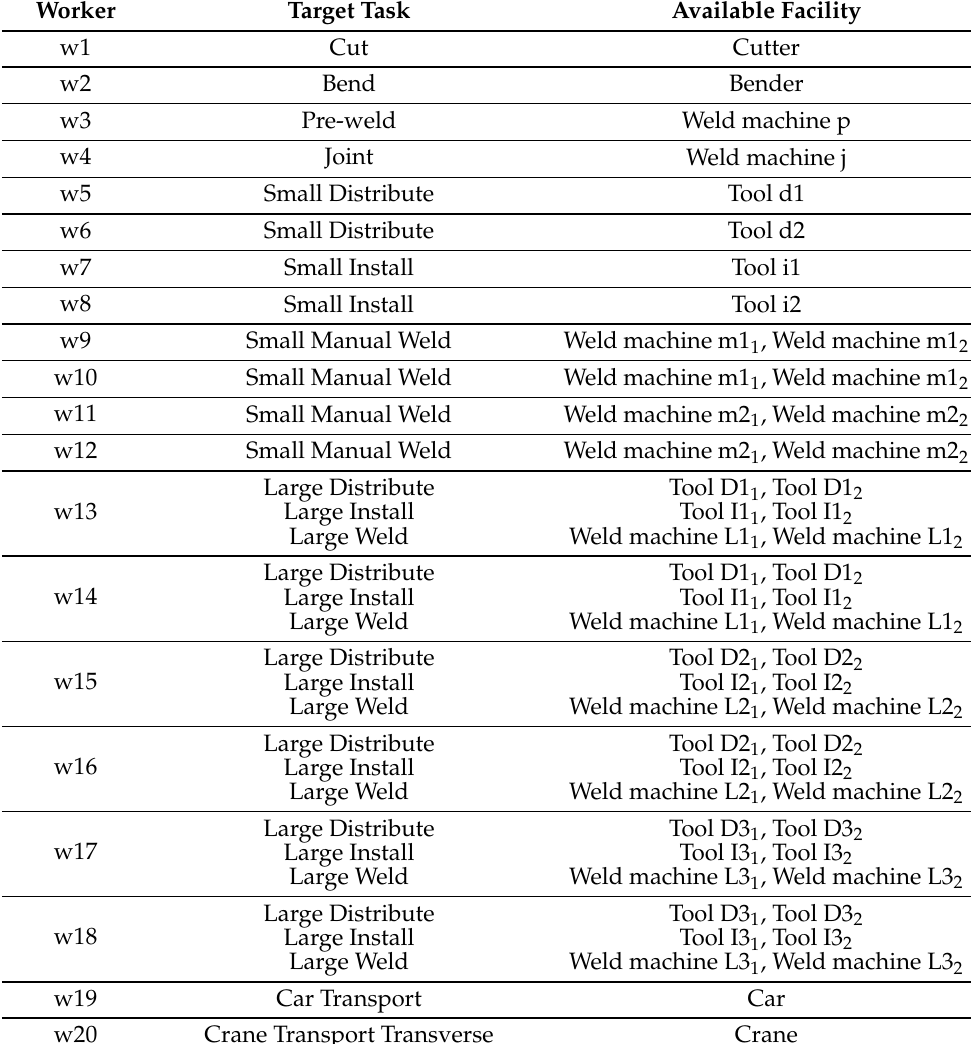
Table 3. Workers Data in Case